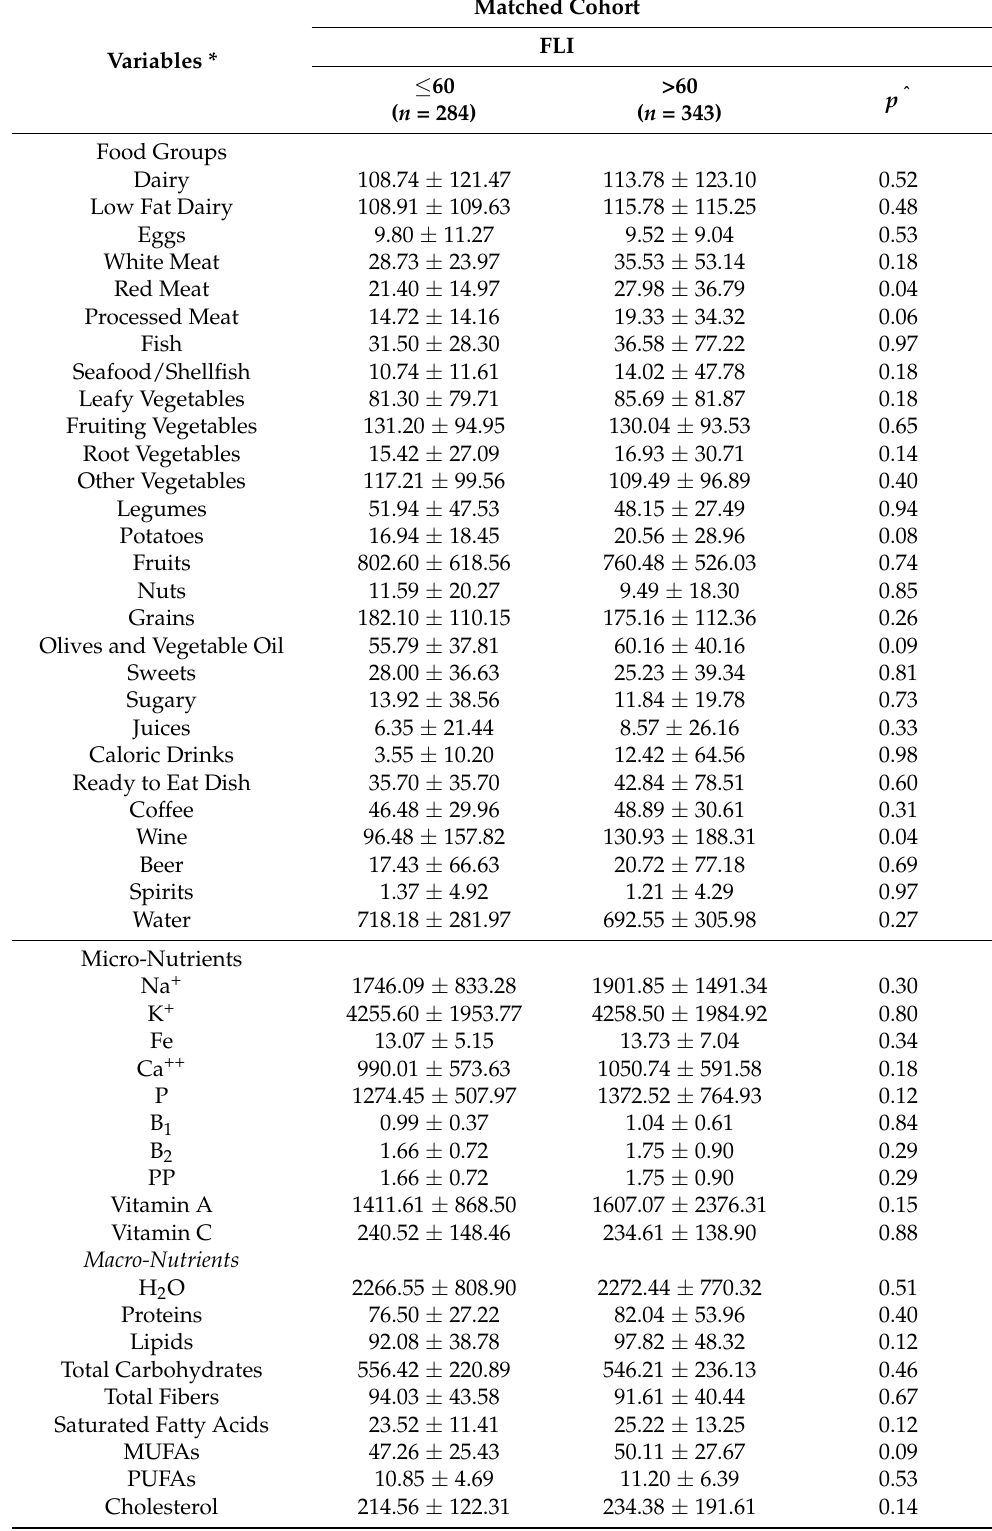
Table 5. Food, micro and macro intake in the matched